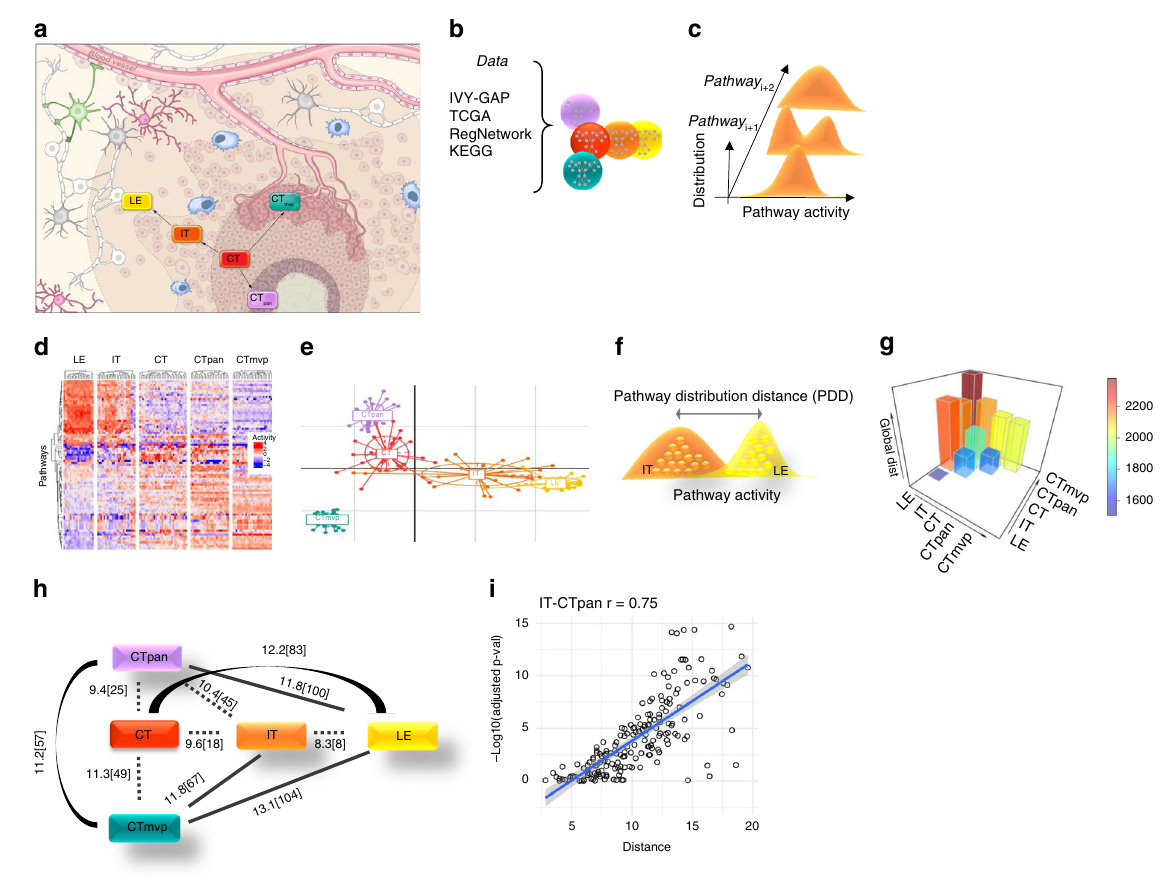
Fig. 1 GBM spatial phenotypic trajectories. Initial analysis of the static data was conducted to assess spatial phenotypic trajectories. Pathways and global distances were calculated for every pair of locations based on population distributions. a Illustration of sampled locations from Ivy GAP datasets,